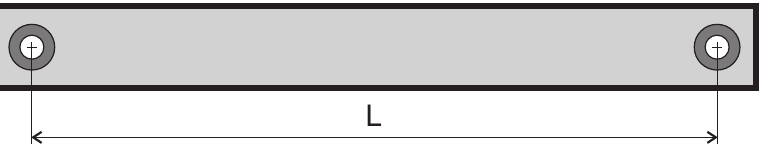
Figure 4. Layout of a cable: The construction length L 0 is affected by manufacturing errors generated during the cutting operation and assembly errors coming from a bad placement of the eyelets necessary to connect two or more